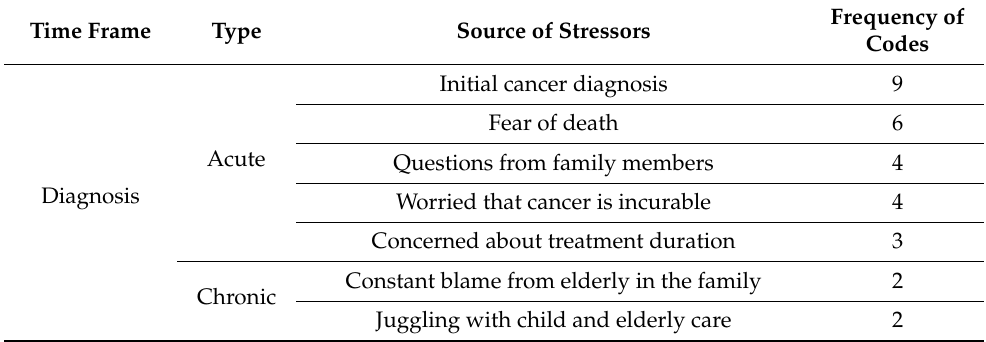
Table 3. Codes representing sources of parental stressors throughout the cancer care